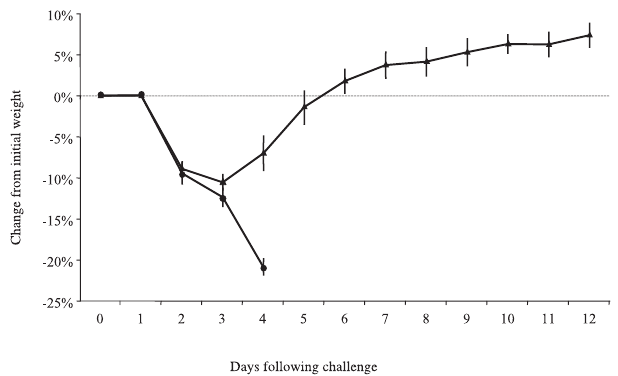
Figure 7. Challenge of SARS-CoV– or Mock-Immunized Mice with the Lethal MA15 Virus Groups of eight mice (8 wk old) were immunized intranasally with 50 l L of SARS-CoV (Urbani) (10 5 TCID 50 /mouse) or L15 tissue culture media. Four weeks after immunization, mice were challenged intranasally with 50 l L MA15 virus (10 6.9 TCID 50 /mouse), weighed daily, and observed twice daily for morbidity and mortality. Surviving mice that lost in excess of 20% initial body weight were euthanized. Symbols represent mean values for SARS-CoV–immunized mice (triangles) and mock-immunized mice (circles). Error bars indicate standard